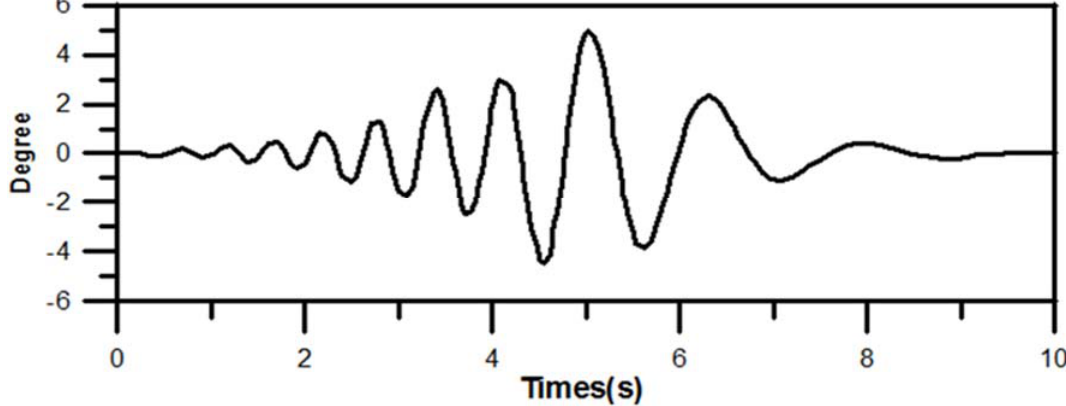
Figure 21. Time ‐ based variations of the flap wavemaker angle used for the generation of a wave packet.